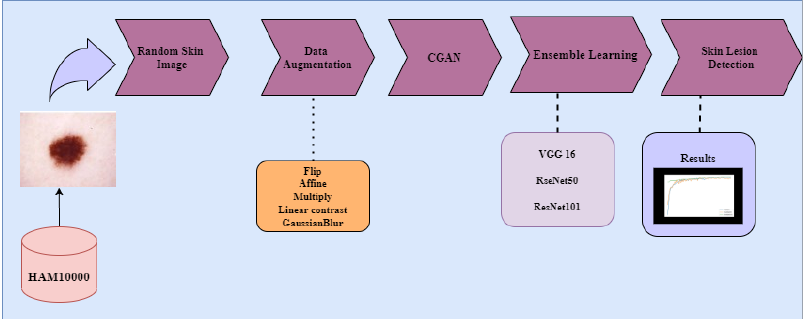
Figure 1. The complete flow of the